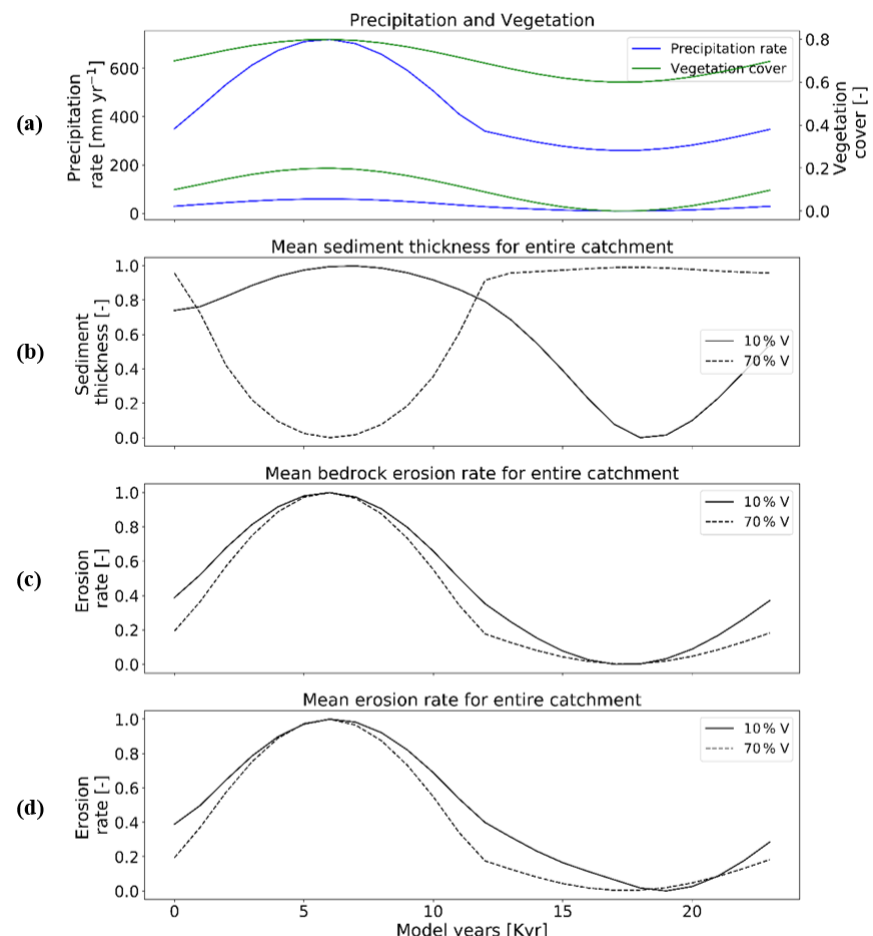
Figure A1. Temporal evolution of catchment-averaged predictions for scenario 3 (with no weathering) described in the text (Sect. 3.3). Graphical representation of normalized mean catchment sedimentation and erosion to (a) coupled oscillations in precipitation [mmyr − 1 ] and vegetation cover [–] in terms of (b) sediment thickness [–], (c) bedrock erosion [–], and (d) mean erosion rate [–] for the entire catchment. The periodicity of climate and vegetation oscillations is 23kyr with a rock uplift rate of 0.5mmyr − 1